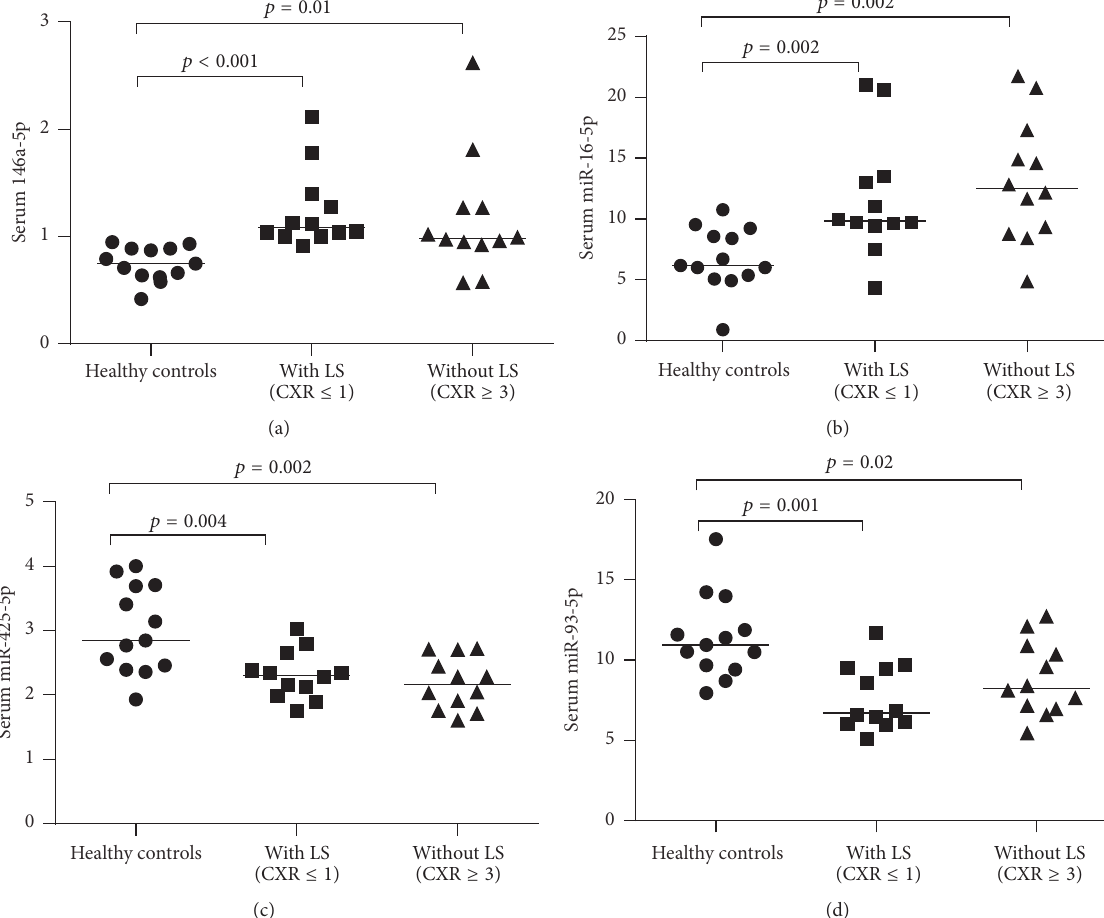
Figure 1: Consistently dysregulated serum miRNAs in both groups of the studied sarcoidosis patients with L¨ofgren’s syndrome and without L¨ofgren’s syndrome compared to healthy controls. CXR, chest X-ray and LS, L¨ofgren’s syndrome.